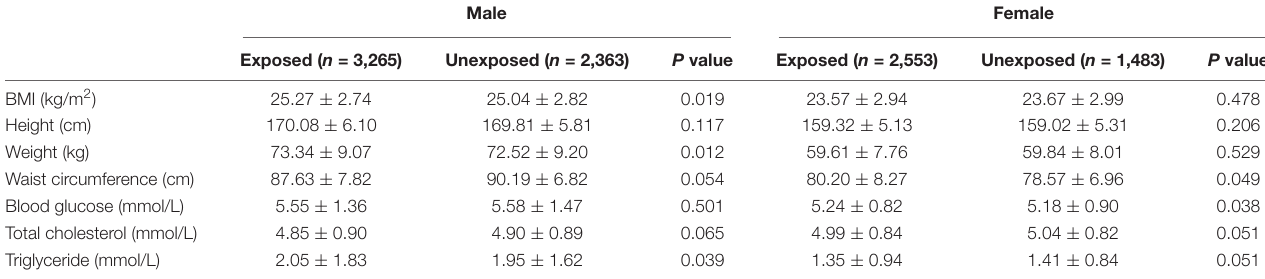
As summarized in Table 2 , blood glucose ( P < 0.05, 95%